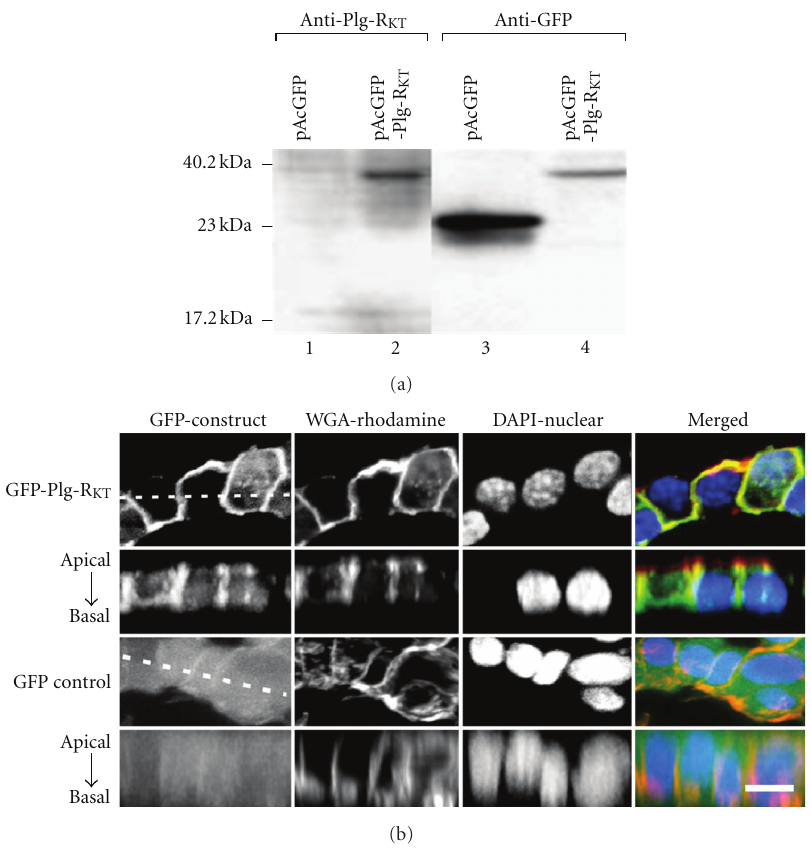
Figure 8: Plg-R KT re-directs GFP to the cell membrane. PC12 cells were transiently transfected with pAcGFP-Plg-R KT (in which the Plg-R KT cDNA was inserted in frame for expression of a GFP-Plg-R KT fusion protein, with Plg-R KT at the C-terminus) or with control pAcGFP vector. (a) Cell lysates were Western blotted with polyclonal anti-Plg-R KT IgG (lanes 1 and 2) or anti-GFP IgG (lanes 3 and 4). (b) The transfected cells were stained with a combination of DAPI and WGA-rhodamine. The first and third panels of images represent maximum projections of a series of optical slices through the cells. The GFP-Plg-R KT signal was localized primarily to the plasma membrane. The second and fourth panels of images represent sagittal (apical-basal) slices through the same cells along the white dotted line indicated. Here the peripheral plasma membrane localization of GFP-Plg-R KT is also evident throughout the vertical stacks of images that were acquired. Scale bar in bottom right corner of image represents 10 microns. [25]. ©The American Society for Biochemistry and Molecular